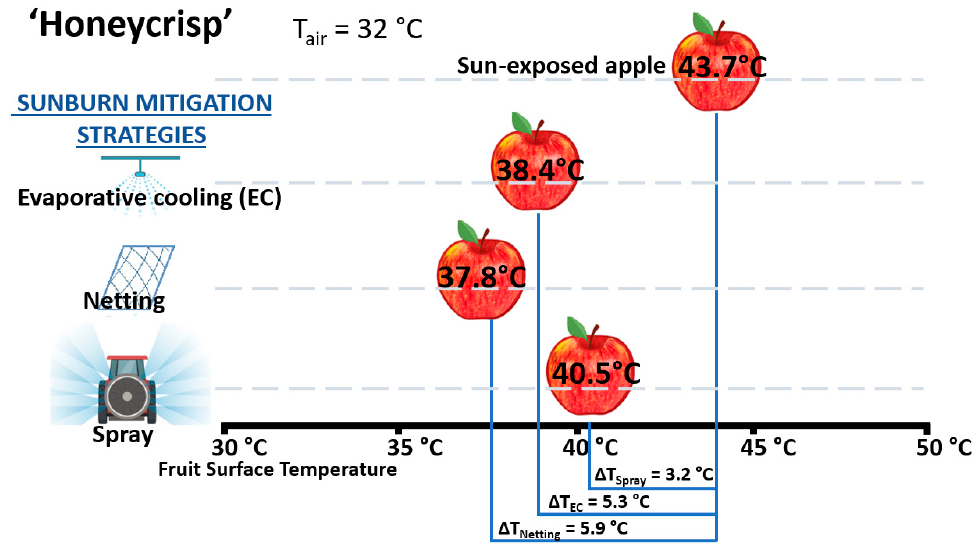
Figure 4. Comparisons of sunburn mitigation strategies on ‘Honeycrisp’ fruit surface temperatures. Adapted from Reig et al. [56].